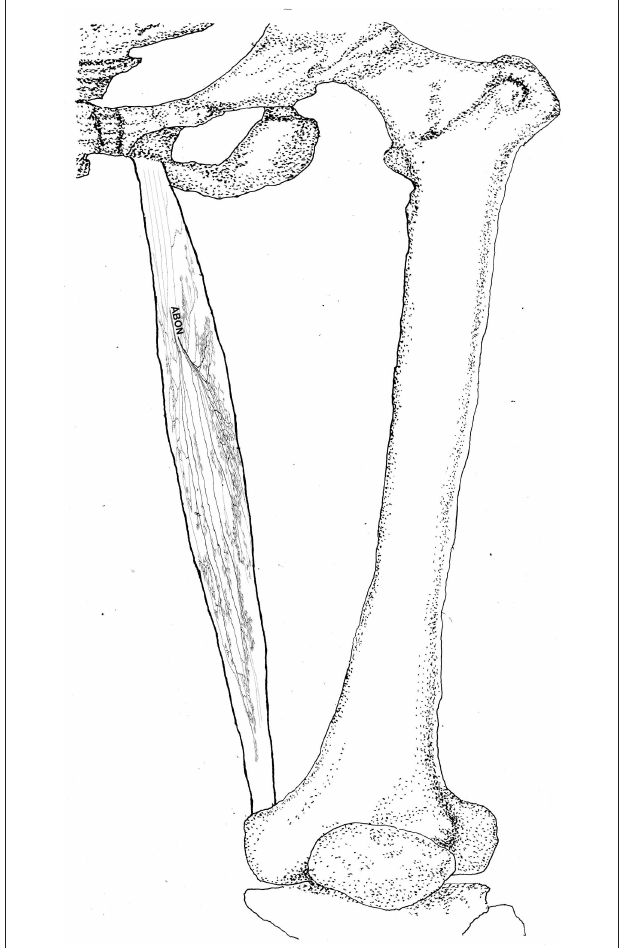
FIGURE 8 | Three dimensional pattern of intramuscular nerve distribution in the gracilis (left, deep side; ABON, anterior branch of the obturator nerve).